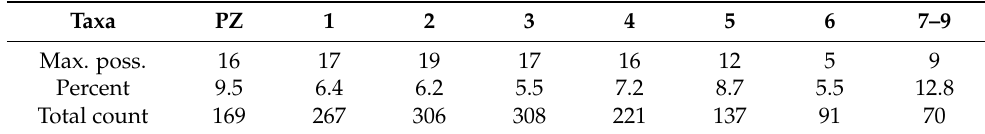
Table 8. Maximal T. scripta and percentage of total excluding T. carolina by level.